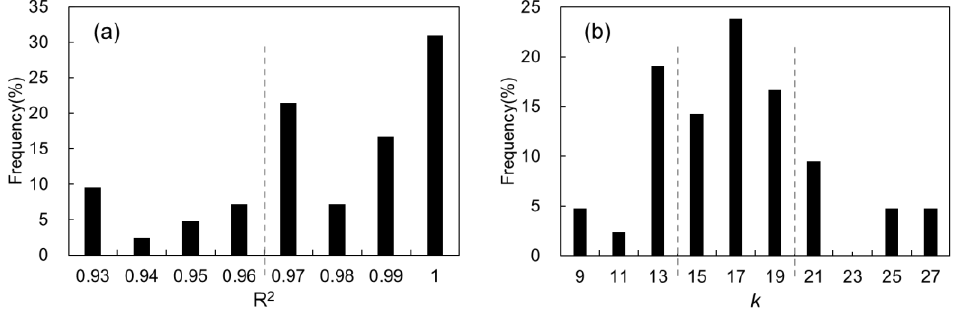
Figure 4. Distribution of R 2 values and k parameter values for Equation (2): ( a ) distribution of R 2 values for Equation (2); ( b ) distribution of k parameter values for Equation (2).